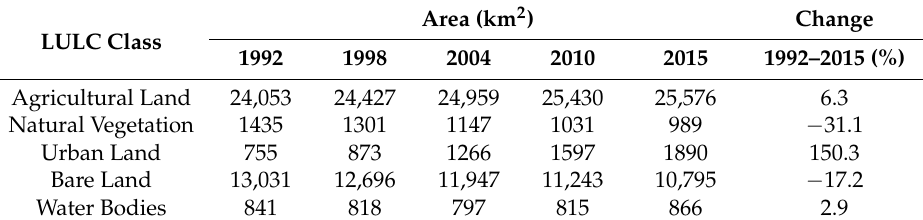
Table 1. LULC classes total areas across the Nile Delta over the study period.